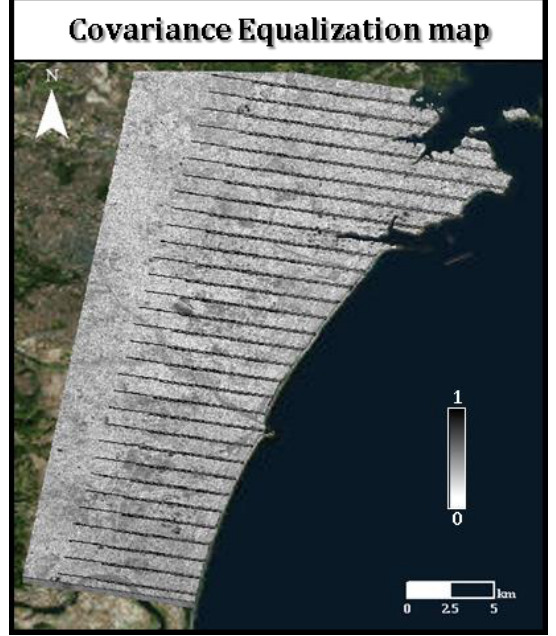
Figure 3. Covariance equalization map. Low values (close to 0, white in the scale) represent no change=stablility. High values (close to 1, black) represent severe damage.